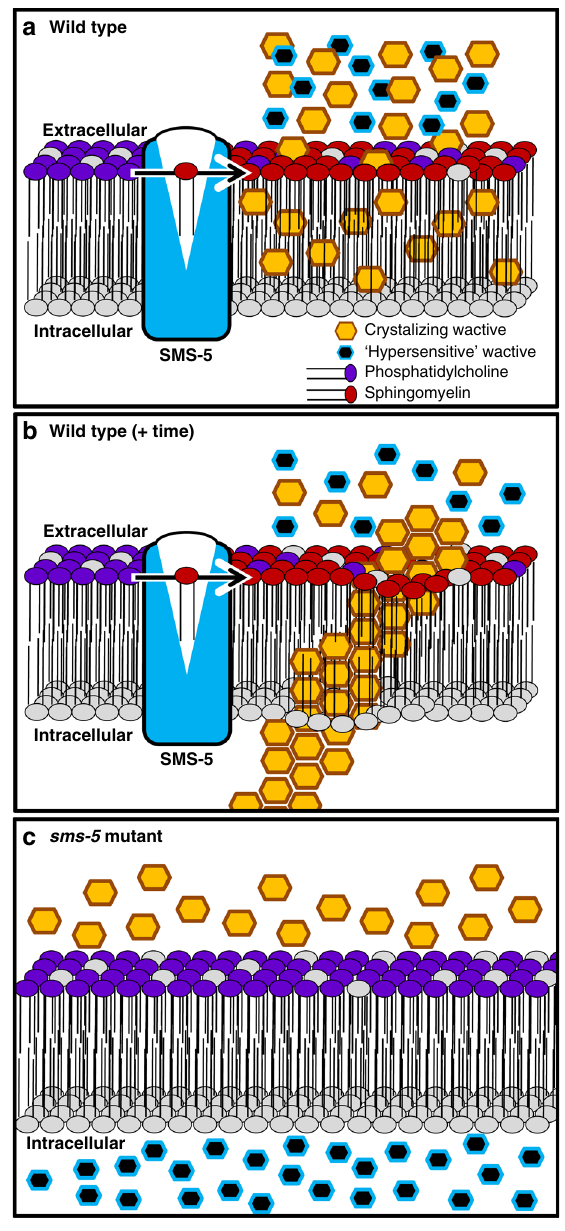
Fig. 10 A model of SMS-5 ’ s role in small molecule accumulation. a SMS-5 is key in synthesizing sphingomyelin (SM) on the outer lea fl et of the plasma membrane (PM) of the marginal cells of the anterior pharynx. The SM-rich membrane acts as a sink for relatively larger hydrophobic crystallizing wactives but a barrier to comparatively smaller molecules. b Over time, the hydrophobic wactives precipitate out of solution within the SM-rich PM of the wild-type marginal cells of the anterior pharynx. c The absence of SMS- 5 results in less SM in the PM, which in turn reduces the accumulation of relatively large hydrophobic molecules. Because of decreased molecular density of a SM-poor PM, relatively smaller molecules can now